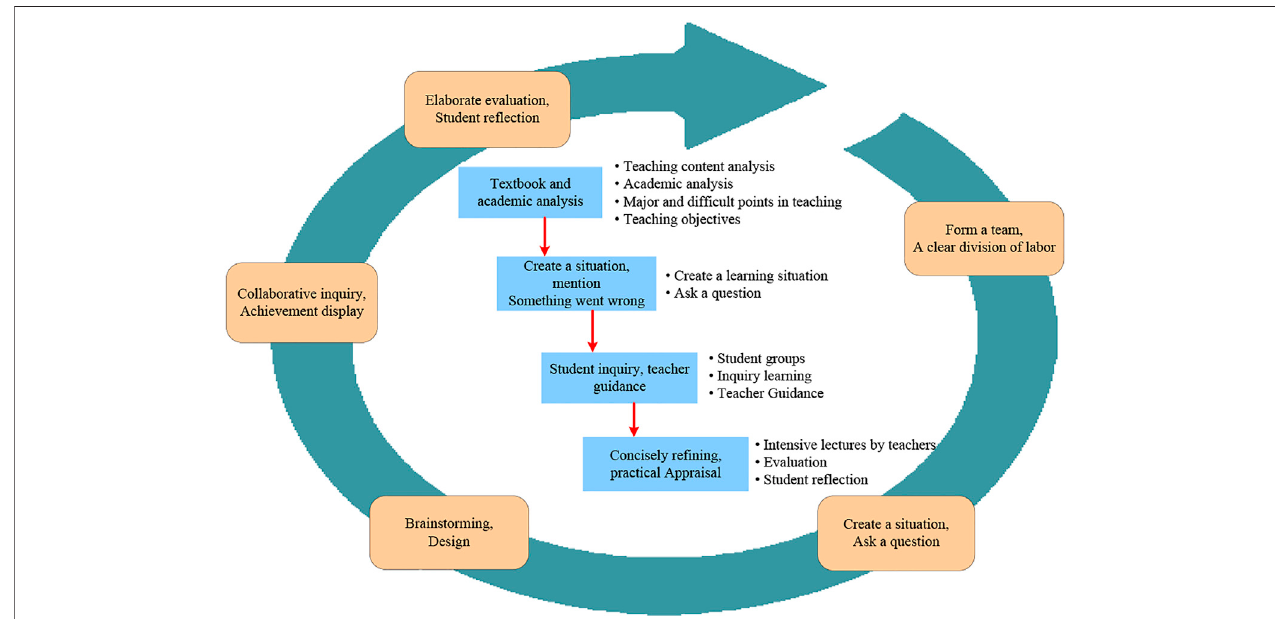
FIGURE 1 | Emergency department PBL teaching implementation plan process.